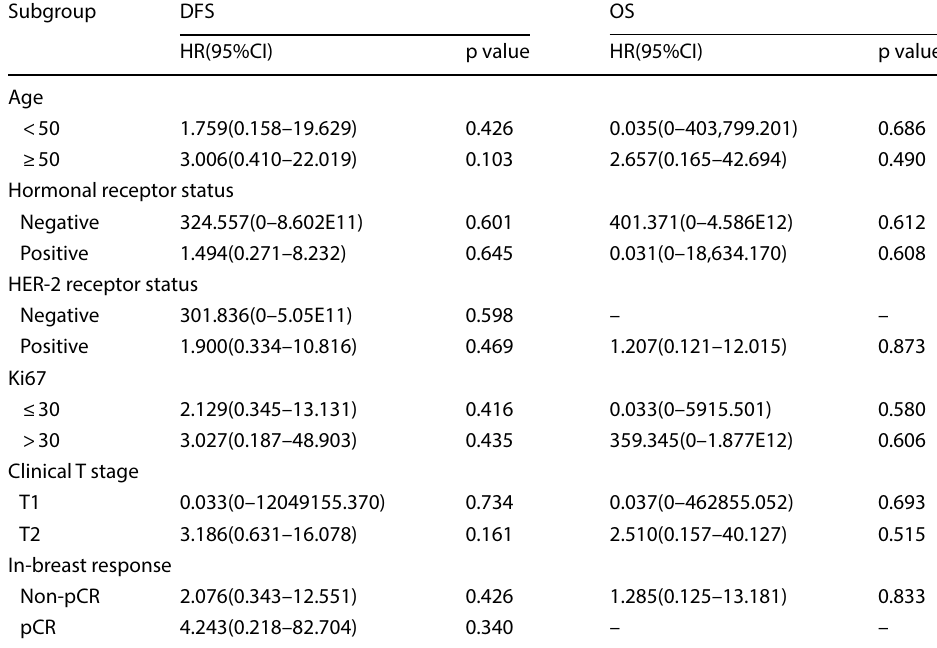
Table 4 Subgroup analysis of disease-free survival and overall survival for all included